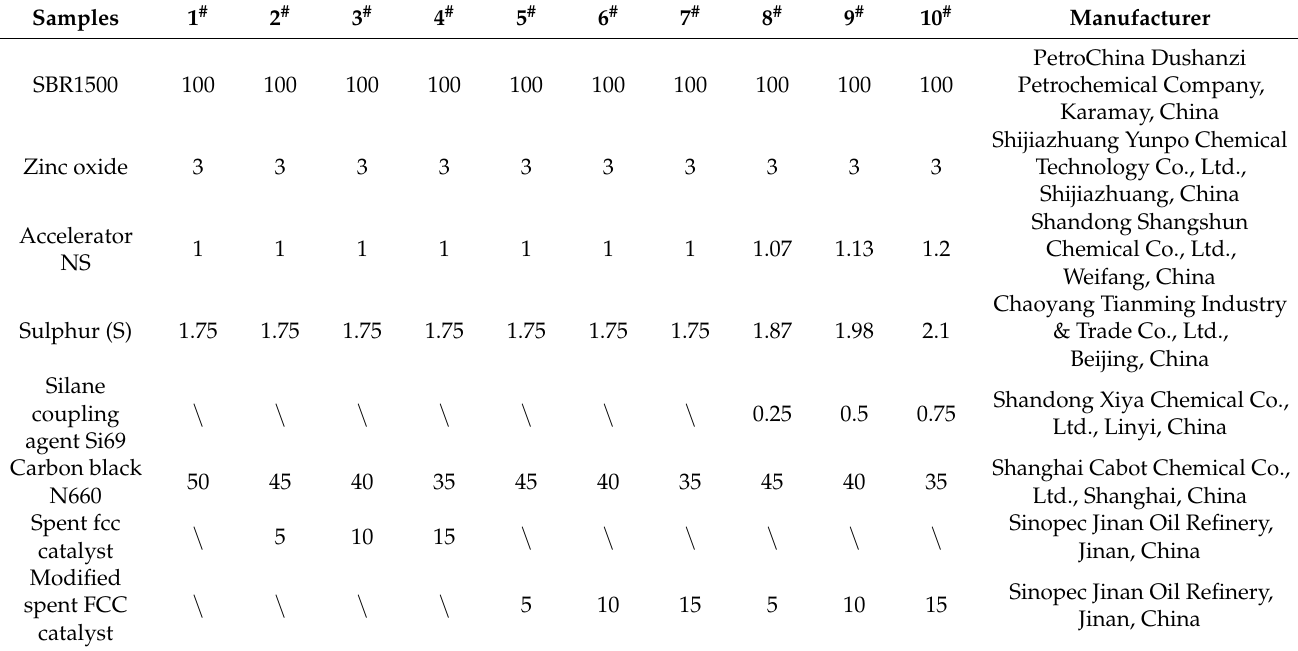
Table 1. Experimental formulation.